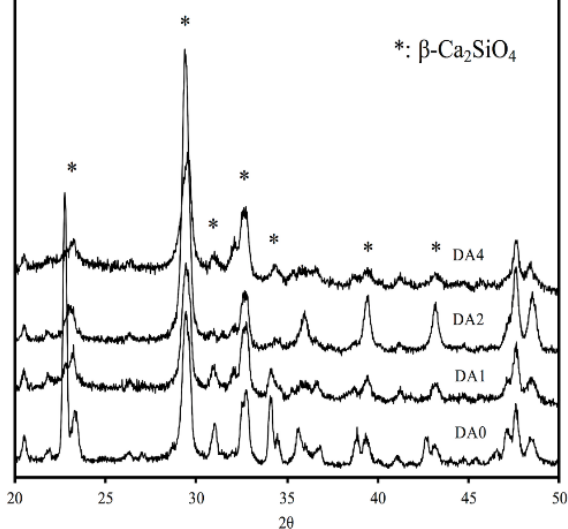
Figure 2. Wide-range XRD patterns of PDA-coated CS cements.